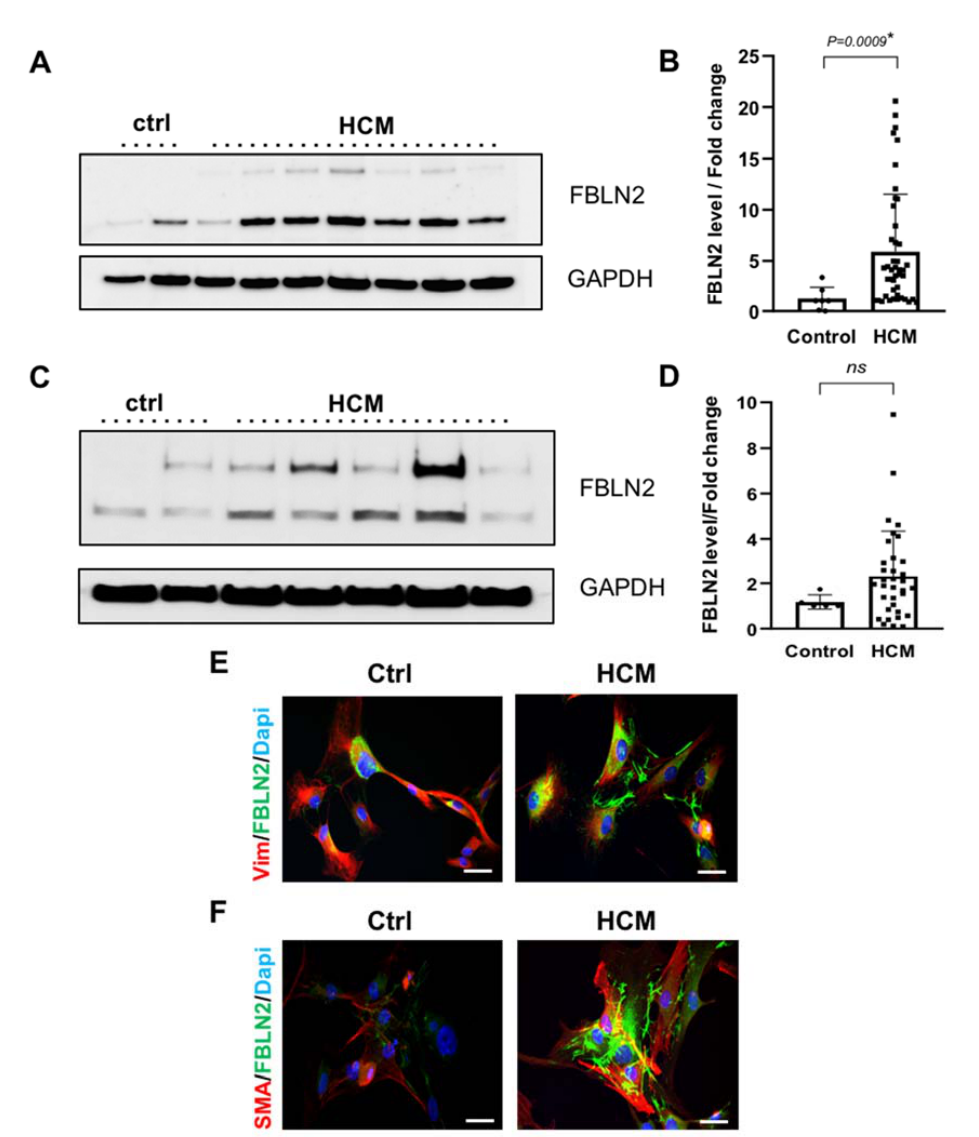
Figure 3. Elevated expression of FBLN2 in HCM myectomy tissues and cultured fibroblasts. ( A ) A representative Immunoblot for HCM and ctrl tissues shows total FBLN2 protein expression normalized to Glyceraldehyde 3 ‐ phosphate dehydrogenase (GAPDH) expression. ( B ) Bar plot shows a significant difference ( P = 0.0009) between mean FBLN2 expression in HCM tissues ( n = 44)